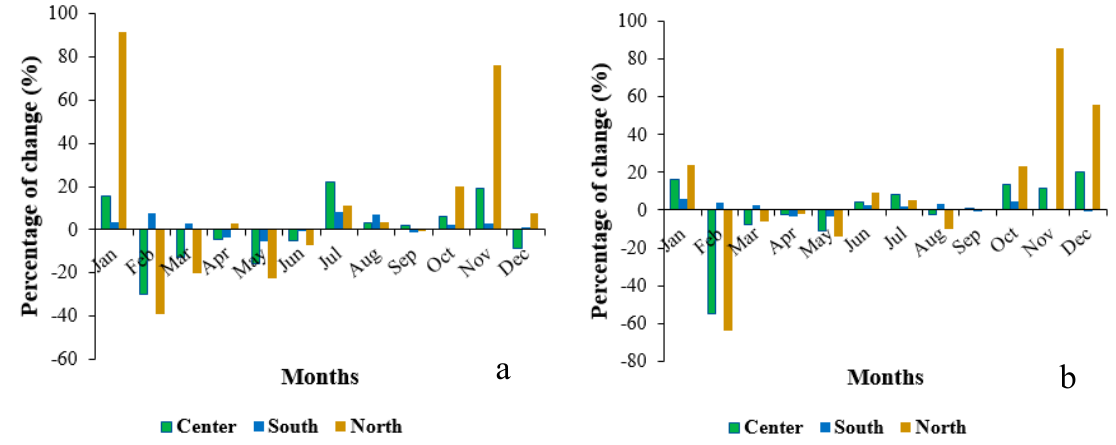
Figure 7. Expected change in rainfall seasonal cycles under RCP4.5 ( a ) and RCP8.5 ( b ).